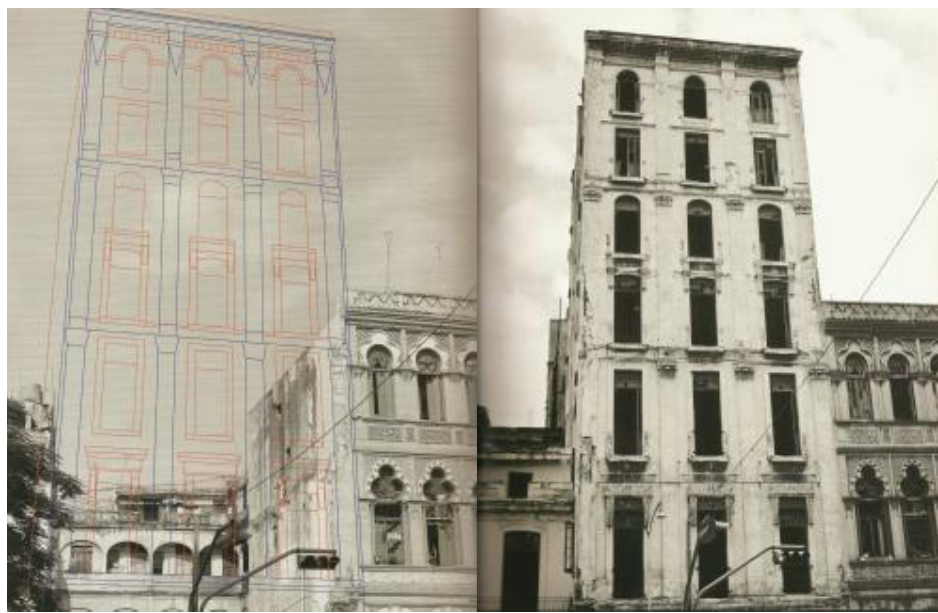
Carlos Garaicoa, Sin título (Hotel San Carlos) [ Untitled (San Carlos Hotel) ] , 1995-2004. Diptych. Photographs and drawing with thread. 123 x 100 cm each. Copyright Carlos